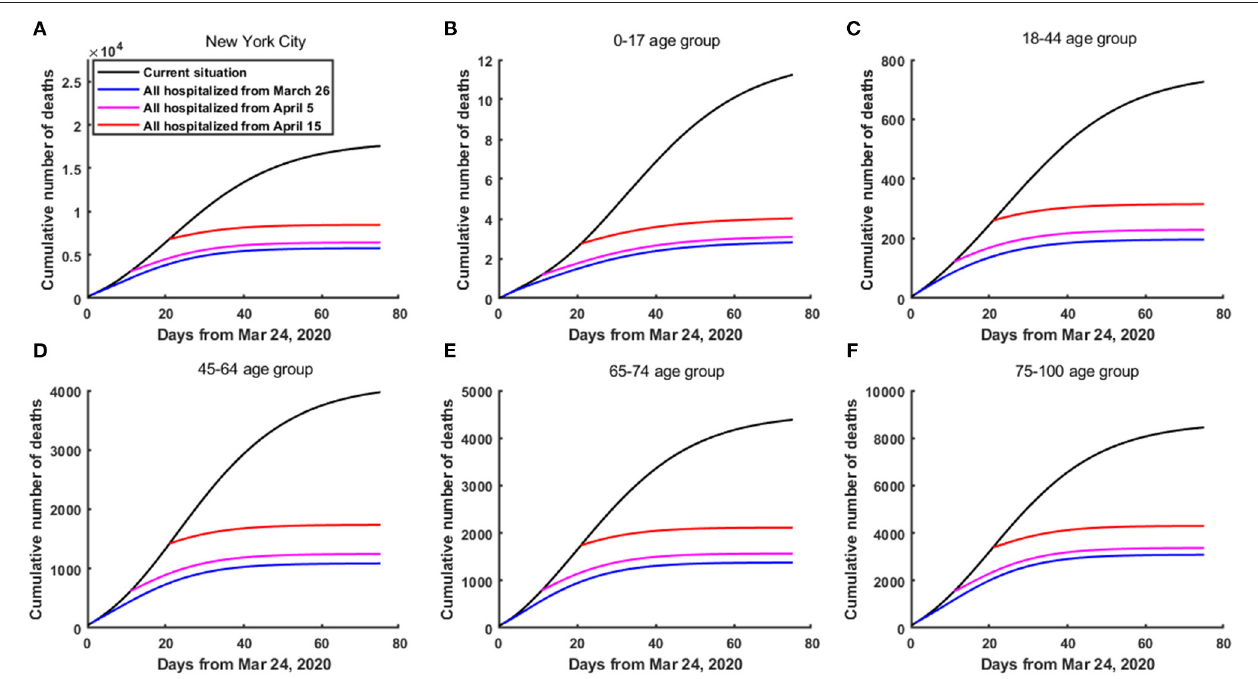
FIGURE 2 | The cumulative number of deaths in NYC if all confirmed cases were hospitalized from March 26, April 5 and April 15, 2020, respectively. (A) In the whole population of NYC. (B) In the 0–17 age group. (C) In the 18–44 age group. (D) In the 45–64 age group. (E) In the 65–74 age group. (F) In the 75–100 age